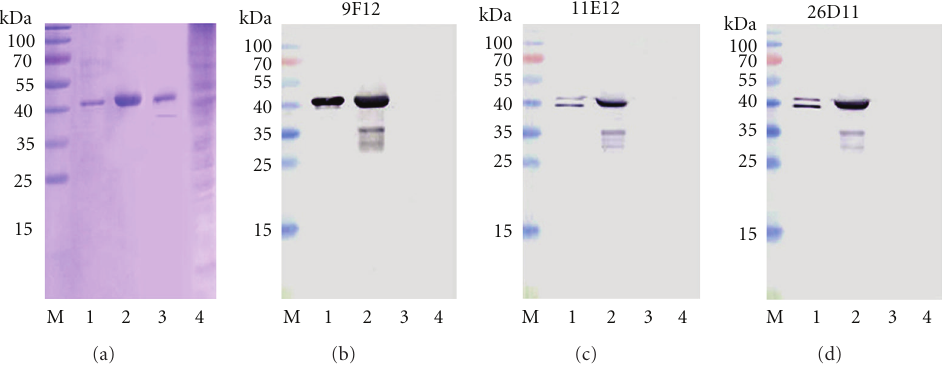
Figure 4: The reactivity of the MAbs raised against VP1/VP2-p16 INK4A pseudotype VLPs with the p16 INK4A protein sequence in Western blot. (a) Coomassie blue-stained SDS-PAGE. (b–d) Western blot with the MAbs raised against pseudotype VLPs, clones 9F12 (b), 11E12 (c), and 26D11 (d). Lane M: prestained protein molecular mass marker (Thermo Scientific Fermentas); lane 1: purified GST-fused p16 INK4A protein; lane 2: purified pseudotype VP1/VP2-p16 INK4A VLPs; lane 3: purified nonmodified VP1/VP2 VLPs; lane 4: crude lysate of nontransformed S. cerevisiae cells.